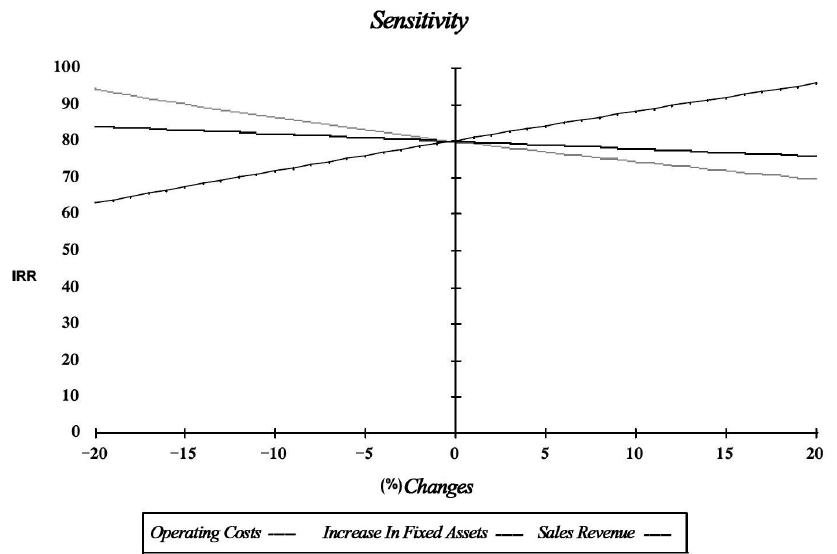
Figure 3. Sensitivity and IRR